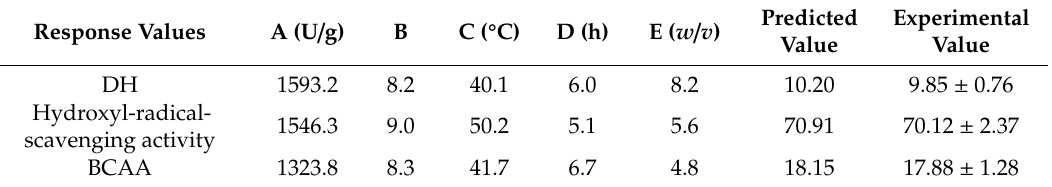
Table 4. Optimal conditions of hydrolysis and model